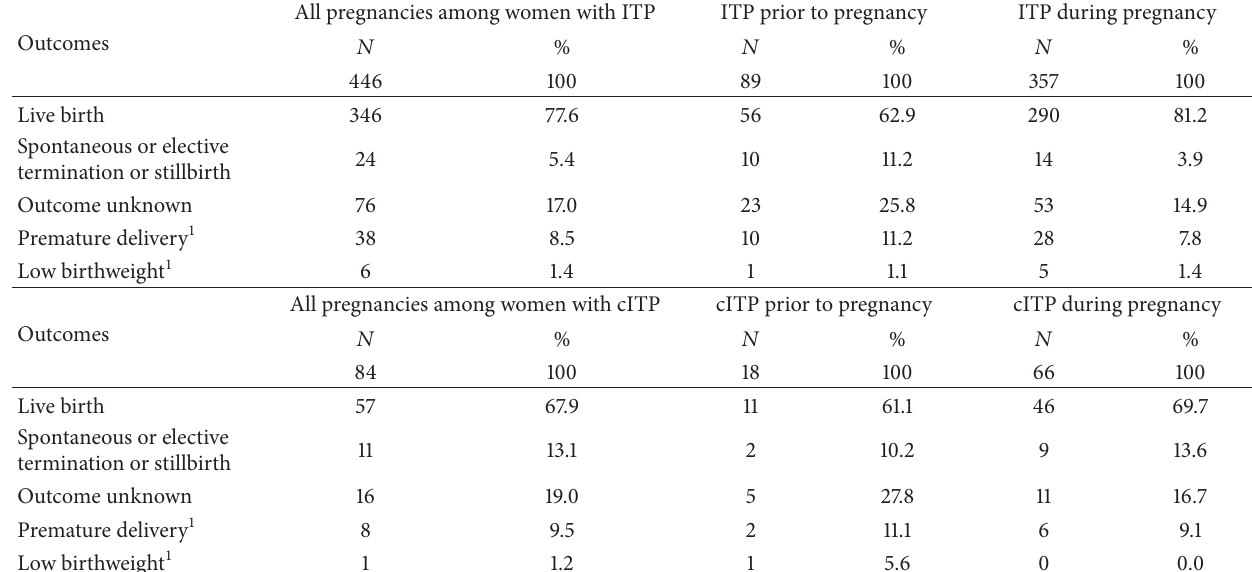
Table 2: Pregnancy outcomes among women with ITP and